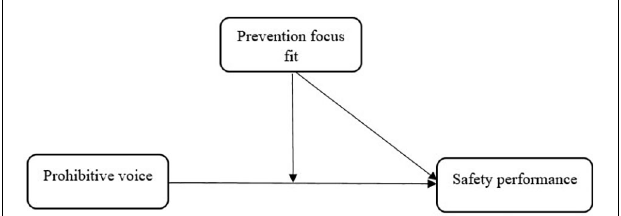
FIGURE 1 | Conceptual